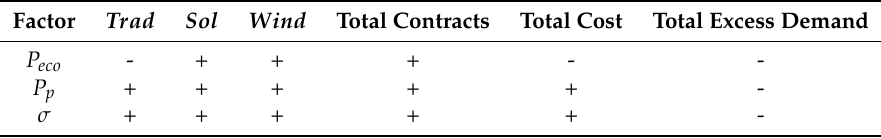
Table 5. Variation of contract capacities, total cost, and total excess demand with respect to P eco , P p , and σ (own results).